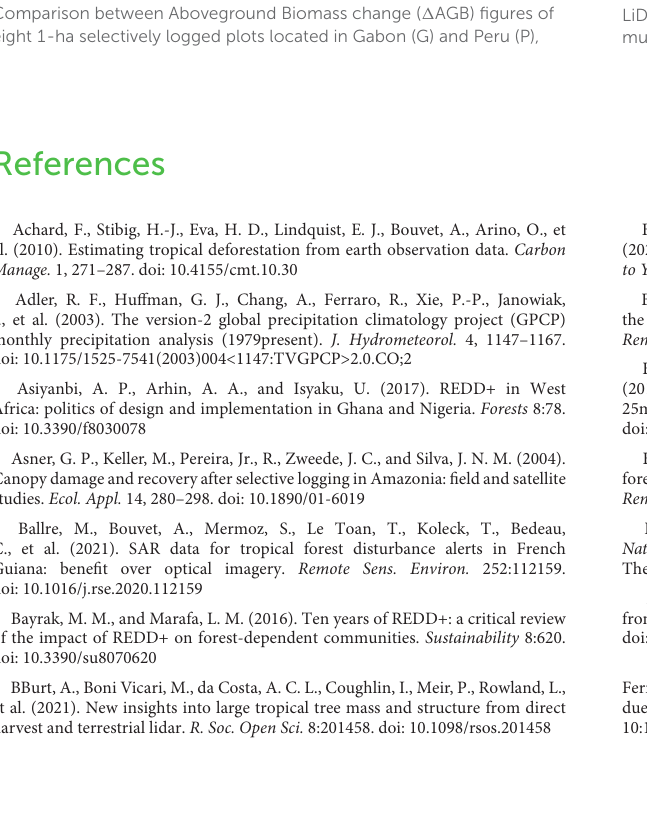
FIGURES4 Comparison of thresholding procedures for change detection. 1) Thresholding using UAV LiDAR data to calculate the value